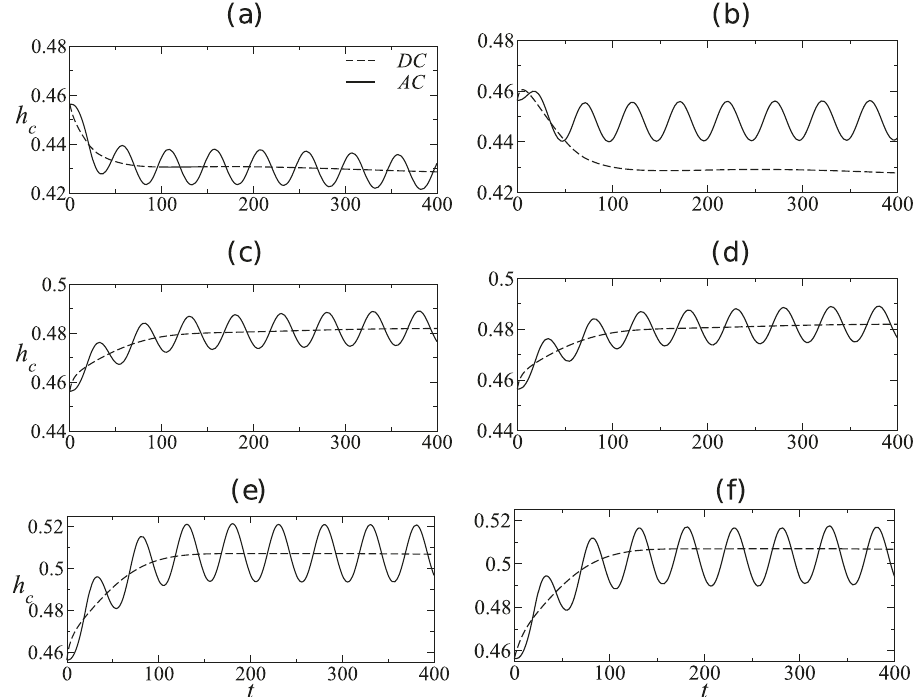
Fig. 2 Comparison of droplet deformation between AC and equivalent DC fi elds. Temporal variation of droplet height, h c : ( a , c , e ) O c = 0.01 and ( b , d , f ) O c = 10. Panels ( a , b ), ( c , d ), and ( e , f ) are for ( ε = 10 and σ = 6), ( ε = 10 and σ = 10), and ( ε = 6 and σ = 10), respectively. Here, for all the AC cases, Ω = π